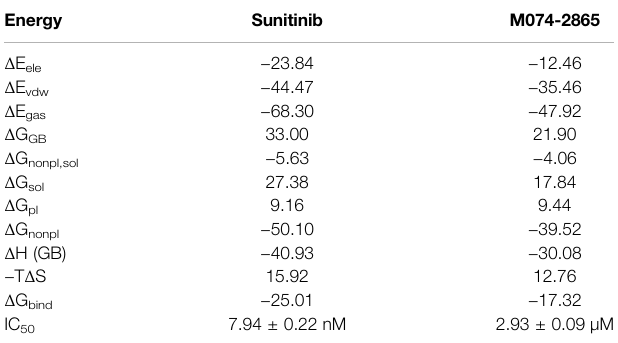
TABLE 3 | Δ G bind for the two inhibitors (sunitinib and compound M074-2865) bound to HPK1 kinase by the MM-GBSA method (kcal/mol). Energy